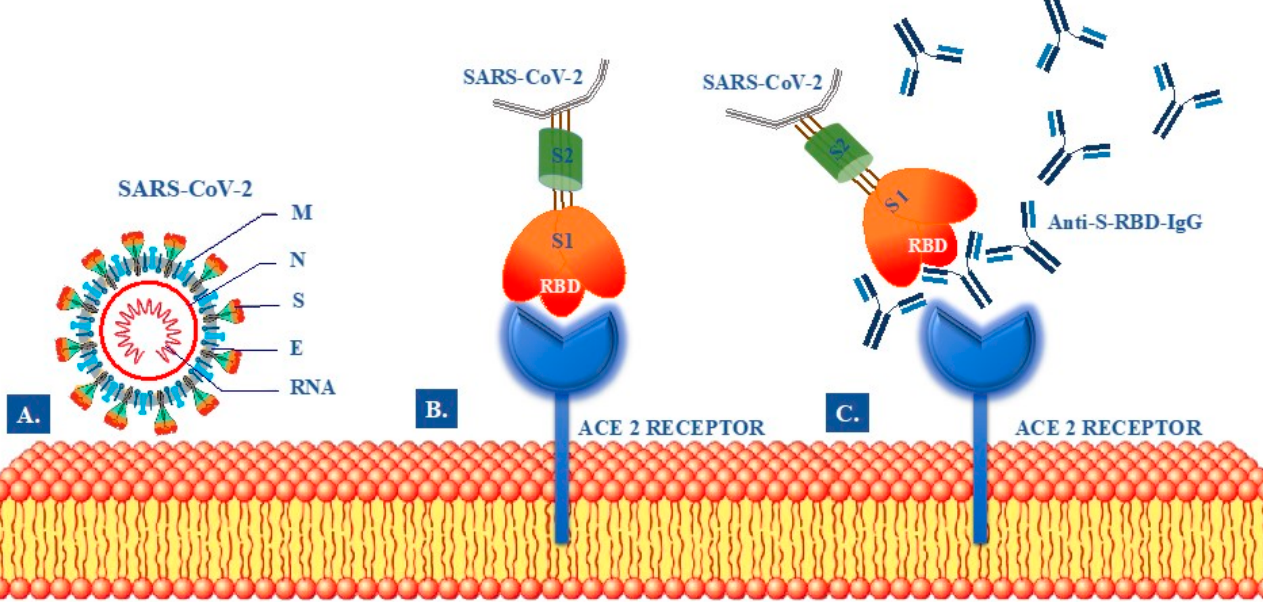
Figure 1. Schematic illustration of postulated mechanism modulating SARS-CoV-2 attachment, fusion and neutralizing activity of anti S-RBD IgG SARS-CoV-2 antibodies. ( A ) Structural components SARS-CoV-2: Envelop Protein (E), Membrane glycoprotein (M), Nucleocapside protein (N), RiboNucleic Acid (RNA), Spike protein (S). ( B ) Binding of Receptor-Binding Domain (RBD) to the Angiotensin-converting enzyme 2 (ACE2) Receptor. ( C ) Inhibition of S-RBD binding to the ACE2 receptor by neutralizing anti-S-RBD IgG